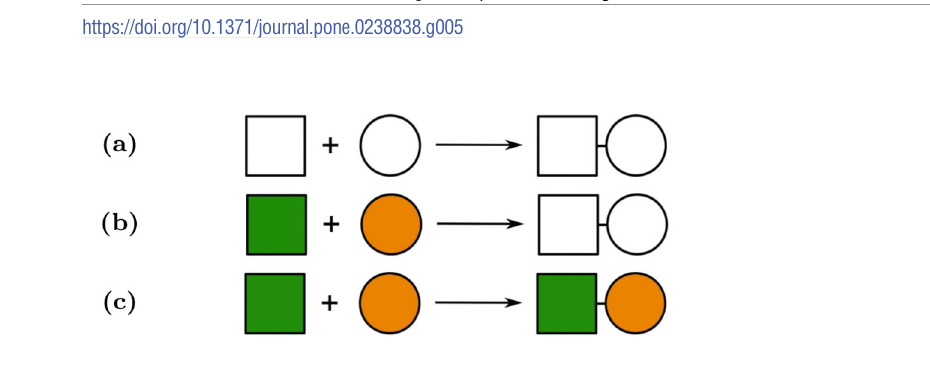
Fig 5. Examples of rules. Rule (A): a square and a circle can form a complex regardless their colours. Rule (B): a square is allowed to change its colour from red to orange only if it is in a complex with a circle regardless its colour. Rule (B): the rule can disassemble the complex only if the circle is